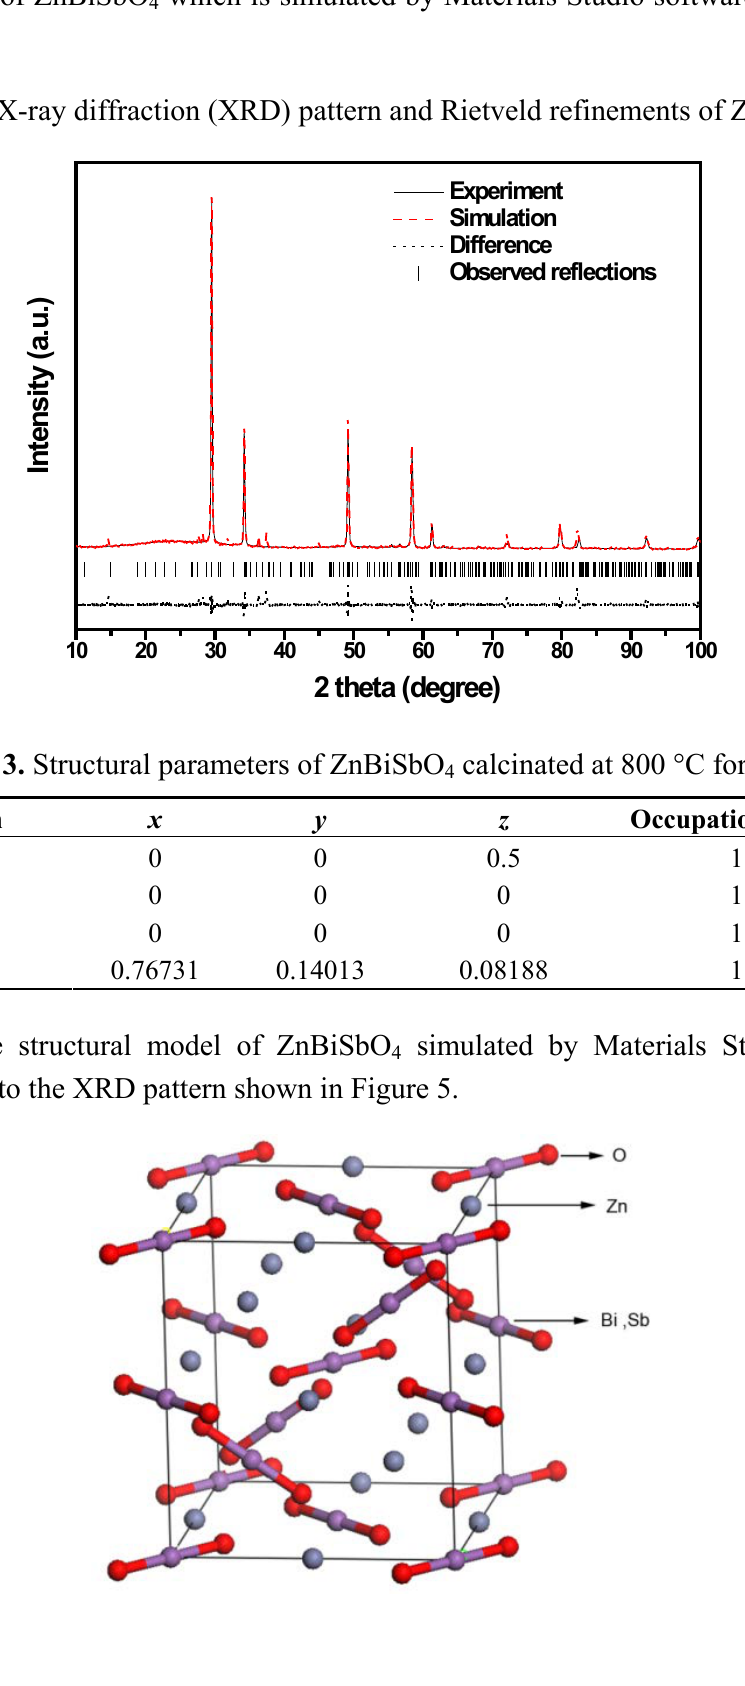
simulated by Materials Studio software 4